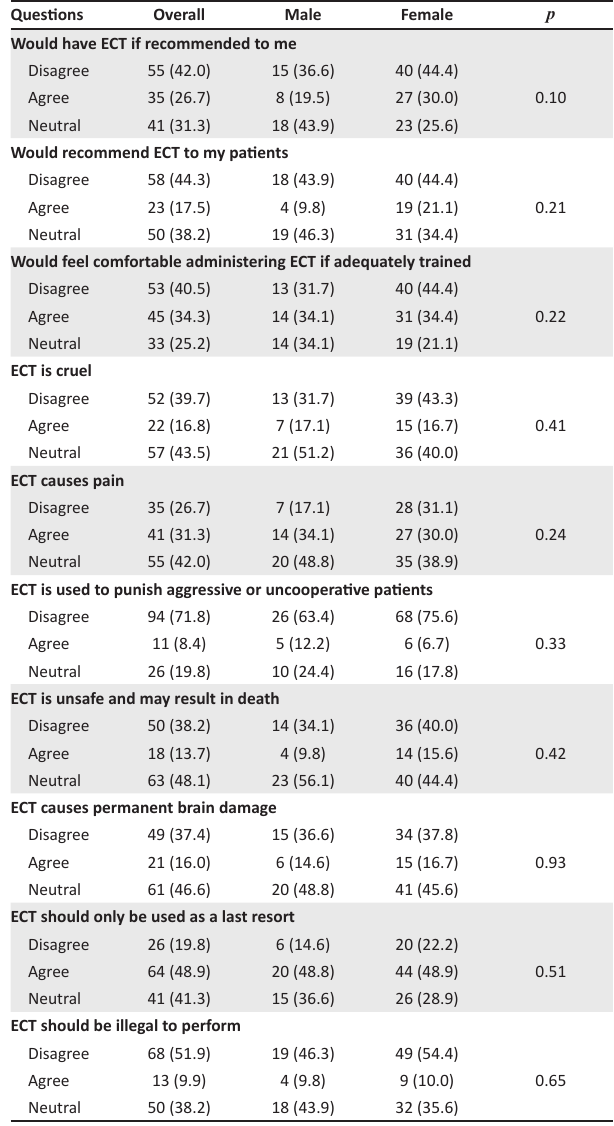
TABLE 2: General attitudes towards psychiatry. TABLE 3: Students’ attitudes towards electroconvulsive